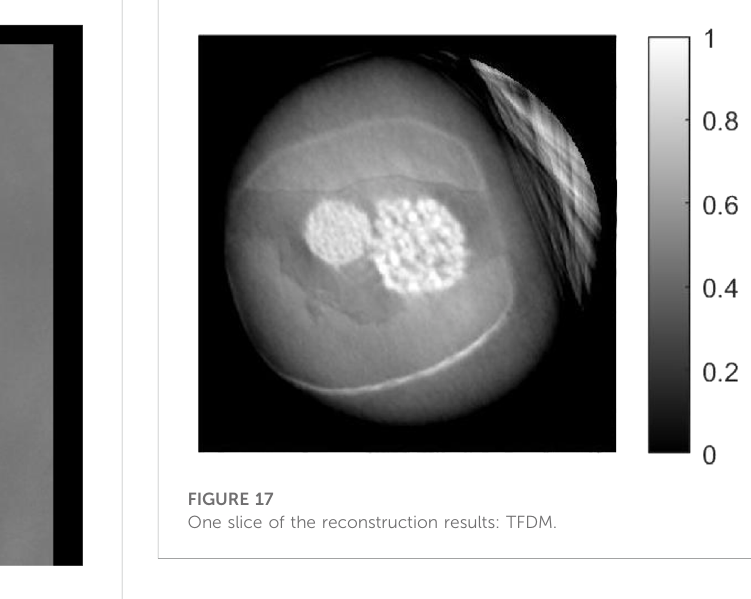
FIGURE 15 Projection data of the fi rst slice.